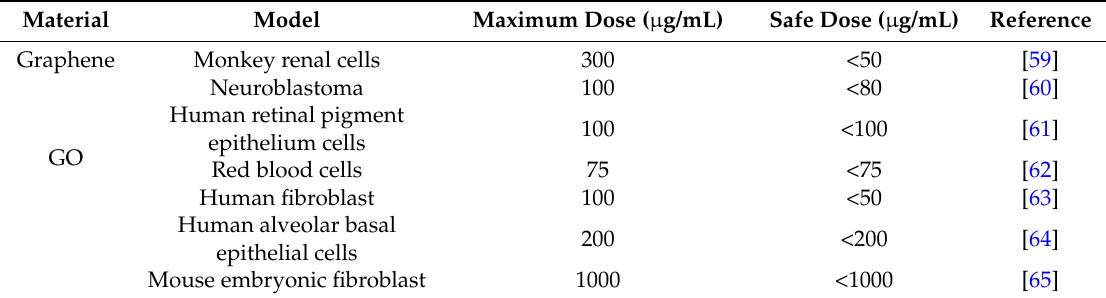
Table 1. Toxicity evaluation of graphene and graphene oxide